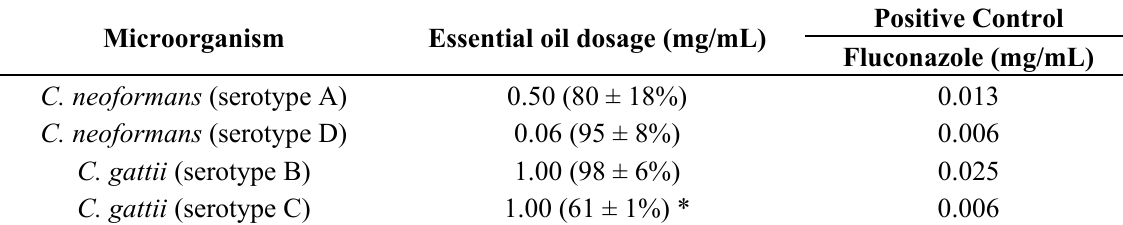
Table 3. Minimum inhibitory concentrations (MICs) obtained from broth microdilution assays for essential oils from the leaves of Porcelia macrocarpa (January